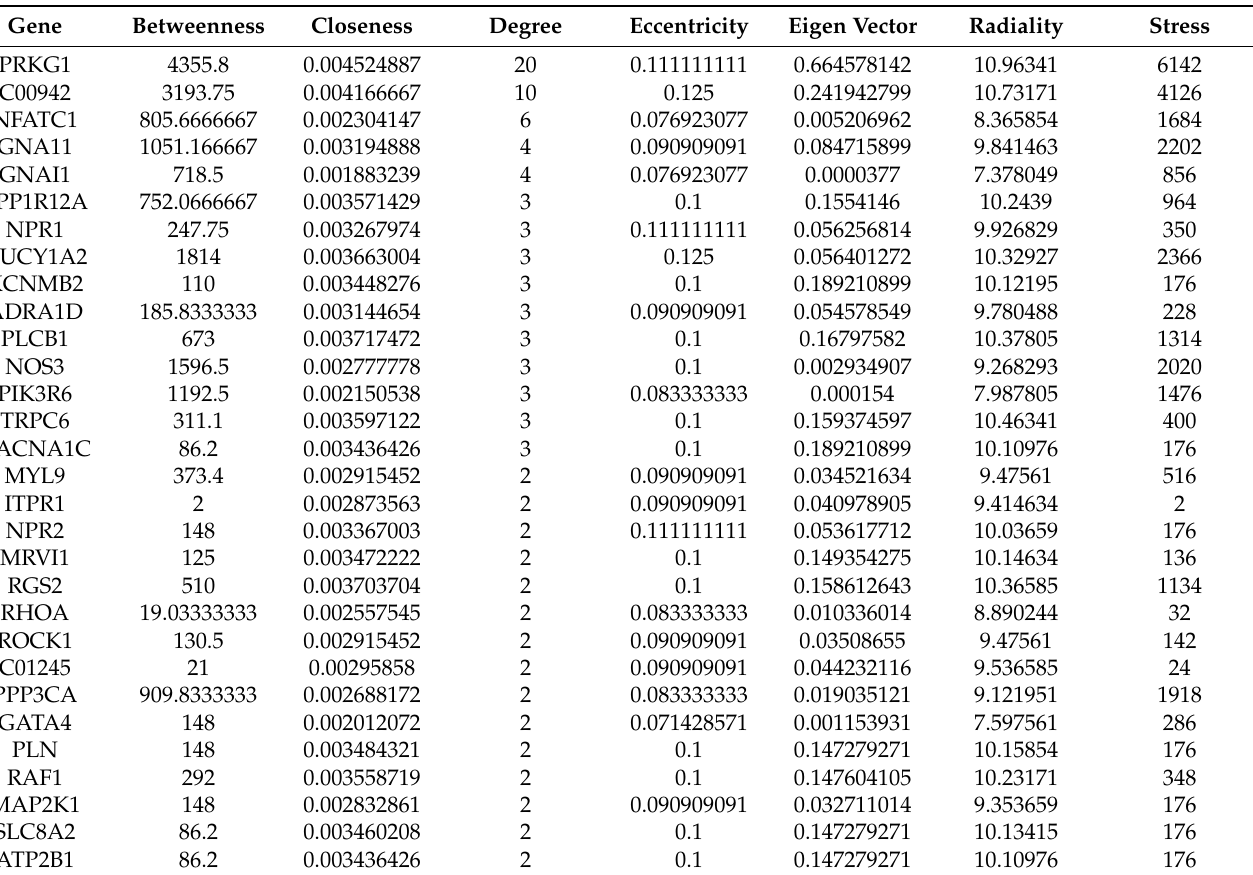
Figure 1. The signaling pathway of phosphodiesterase type 5 (PDE5). Table 1. The results of the threshold parameter values of the phosphodiesterase type 5 enzyme network analysis.